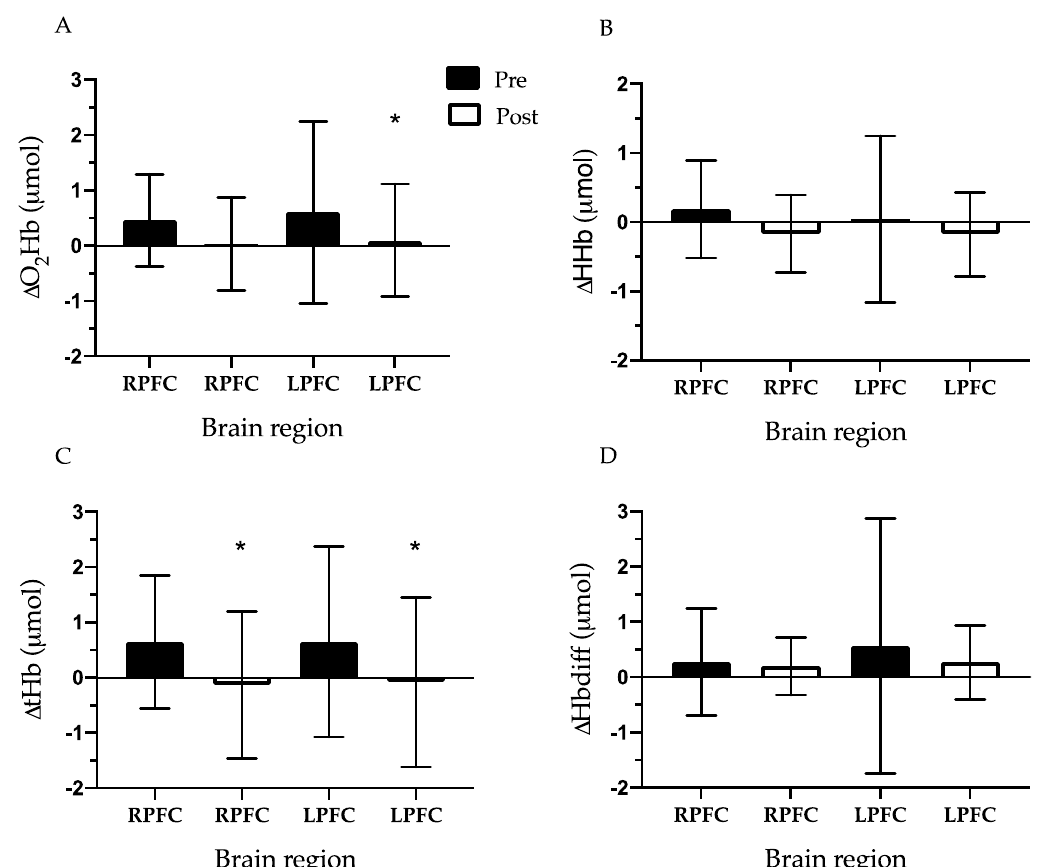
Figure 2. Prefrontal cortex relative changes for functional near infrared spectroscopy measures during the submaximal exercise test pre- and post- cardiac rehabilitation. * significantly lower than pre-cardiac rehabilitation, p < 0.05. ∆ = change from baseline (0 µ mol), O 2 Hb = oxyhemoglobin ( A ), HHb = deoxyhemoglobin ( B ), tHb = total hemoglobin ( C ), Hbdi ff = oxyhemoglobin di ff erence ( D ), LPFC = left prefrontal cortex, RPFC = right prefrontal cortex. Data are mean ± SD, N = 19.